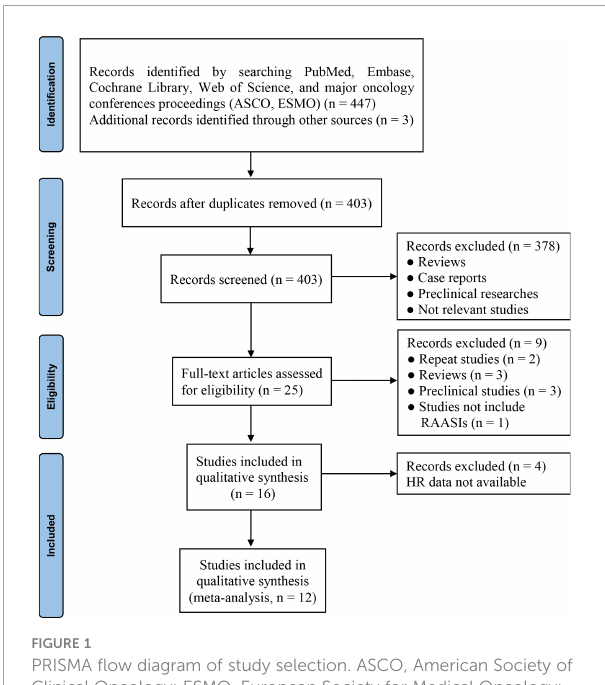
FIGURE 1 PRISMA fl ow diagram of study selection. ASCO, American Society of Clinical Oncology; ESMO, European Society for Medical Oncology; HR, hazard ratio; RAASIs, renin-angiotensin-aldosterone system